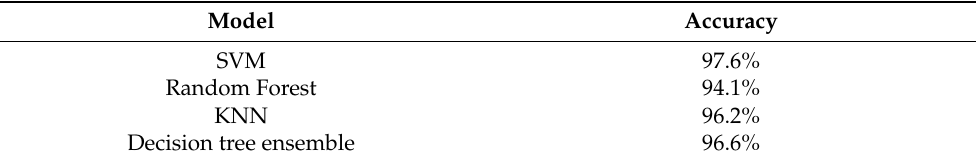
Table 2. Performance comparison between different models.